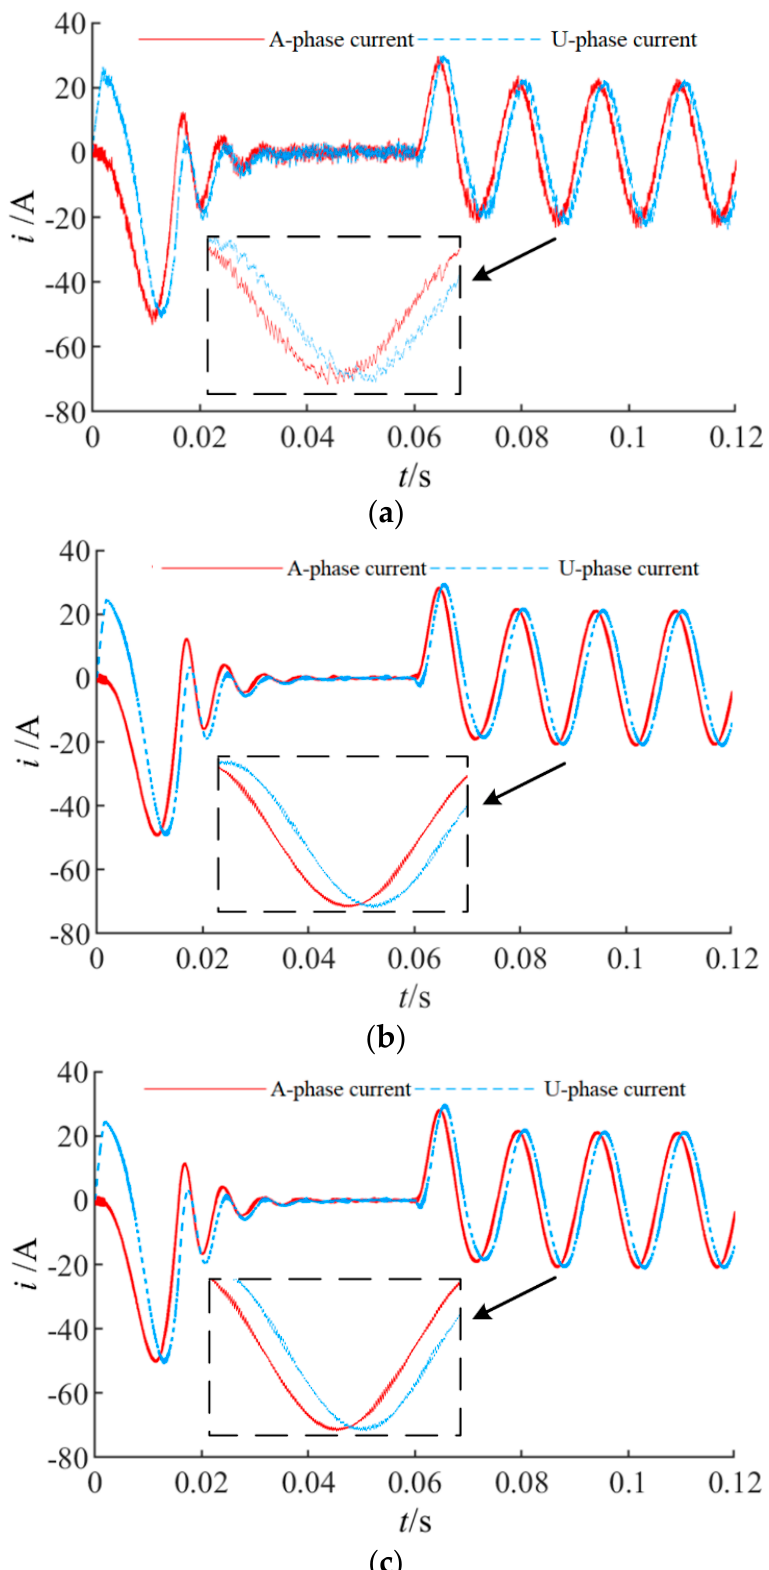
Figure 8. Current waveforms of three current loop control algorithms. ( a ) Traditional MPC in the current loop; ( b ) First-order MPC in the current loop; ( c ) Second-order MPC in the current loop.